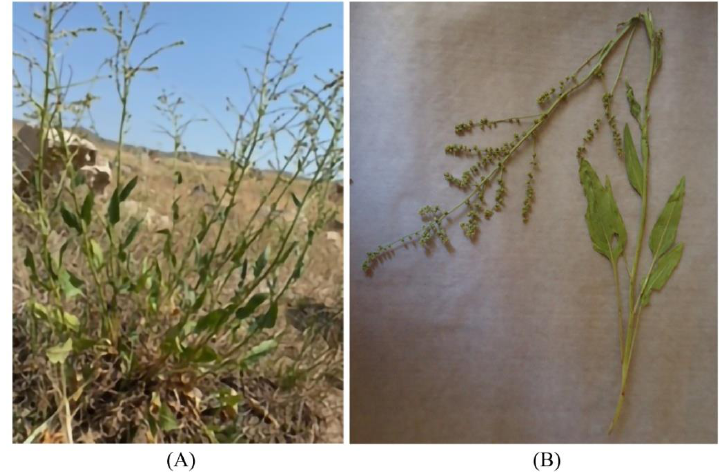
Figure 3. Beta lomatogona species in their natural habitat ( A ) and a herbarium specimen ( B ). Akunq village (1789 m a.s.l.), Aragatsotn marz, the Republic of Armenia (RA), 2 July 2021.